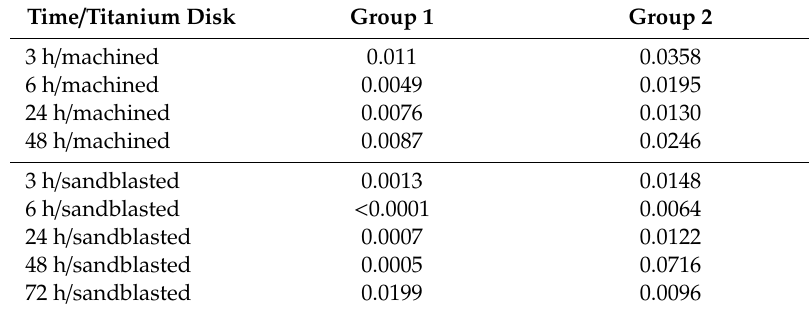
Table 3. Di ff erences ( P -values) of adhesion between Group 3 (PE: pre-eclampsia) vs. Groups 1 ( < 40) and 2 ( >